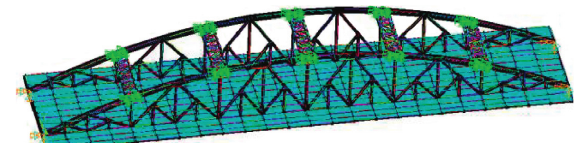
Figure 15: Finite element model of the reinforced